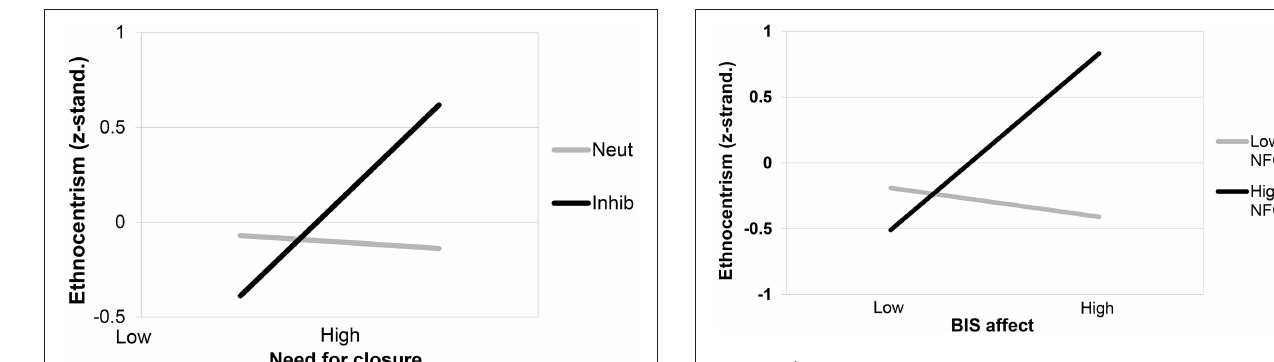
notwithstanding the PANAS, F (1 , 65) = 49.64, p < 0.001, η 2